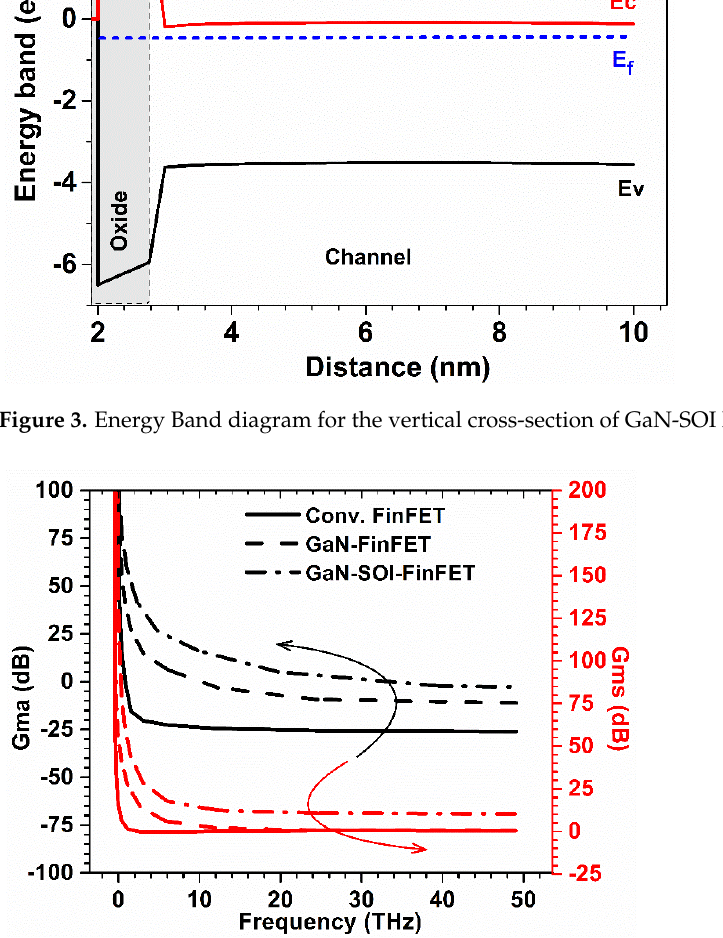
Figure 5. ( a ) SS and Current Gain for Conventional and GaN-SOI-FinFET. ( b ) Unilateral Power Gain and G MT for Conventional and GaN-SOI-FinFET.